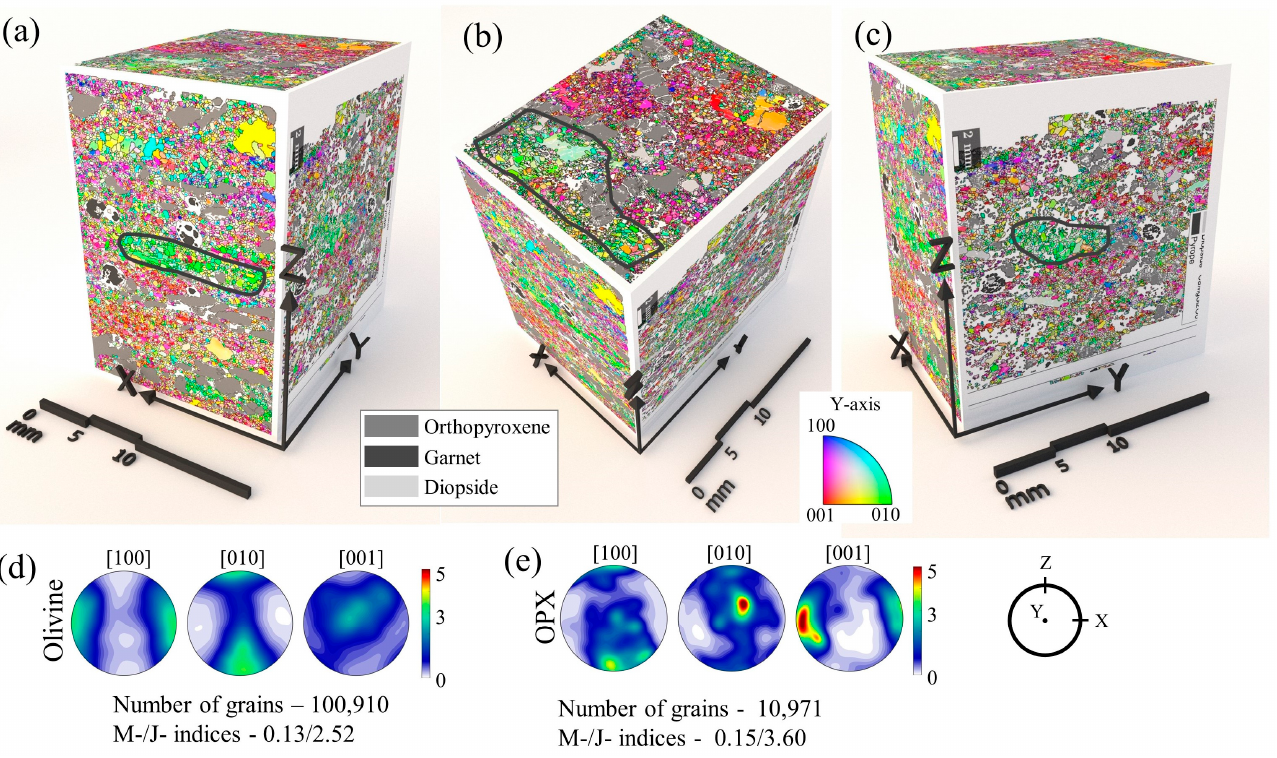
Figure 2. 3-D representation of the microstructure on three orthogonal planes: ( a ) X-Z plane, ( b ) X-Y plane, and ( c ) Y-Z plane. Note that the three planes shown are not spatially connected at their edges. ( d , e ) Pole figures (area-weighted) of the crystallographic preferred orientation (CPO) for olivine ( d ) and orthopyroxene ( e ). Dark outlined polygons delineate the characteristic shape of three groups of grains with self-consistent orientations.